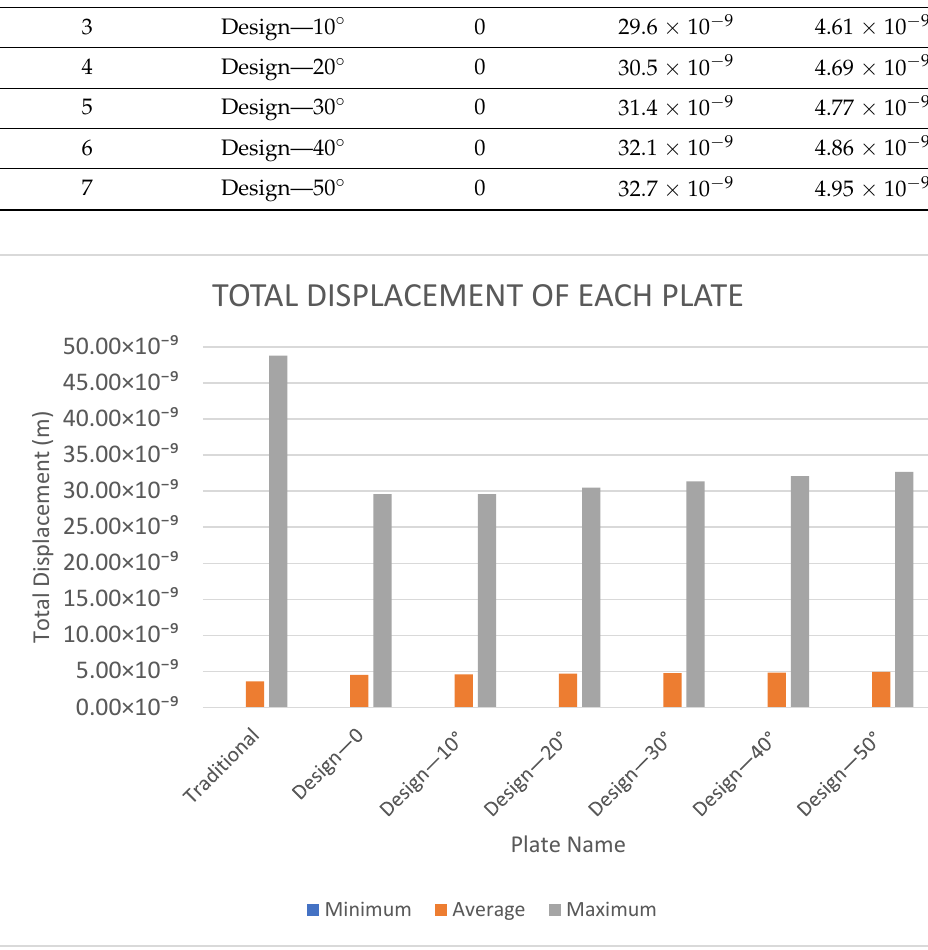
Table 3. Von Mises stress (N/m 2 ) of each plate.